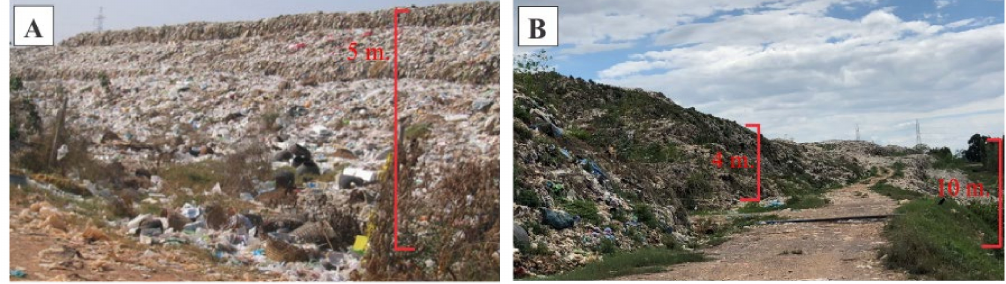
Figure 1. Photos of existing municipal landfill taken in 2004 ( A ) and 2019 ( B